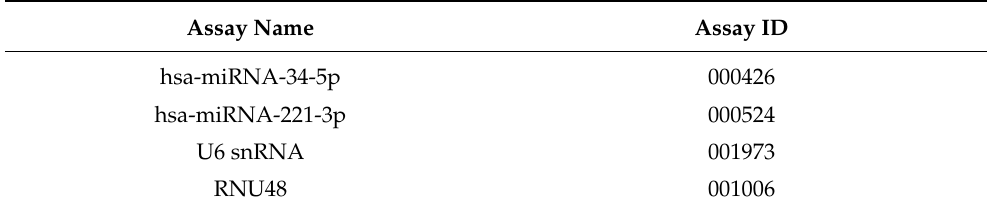
Table 1. MiRNA Primers used in the study. Assay Name Assay